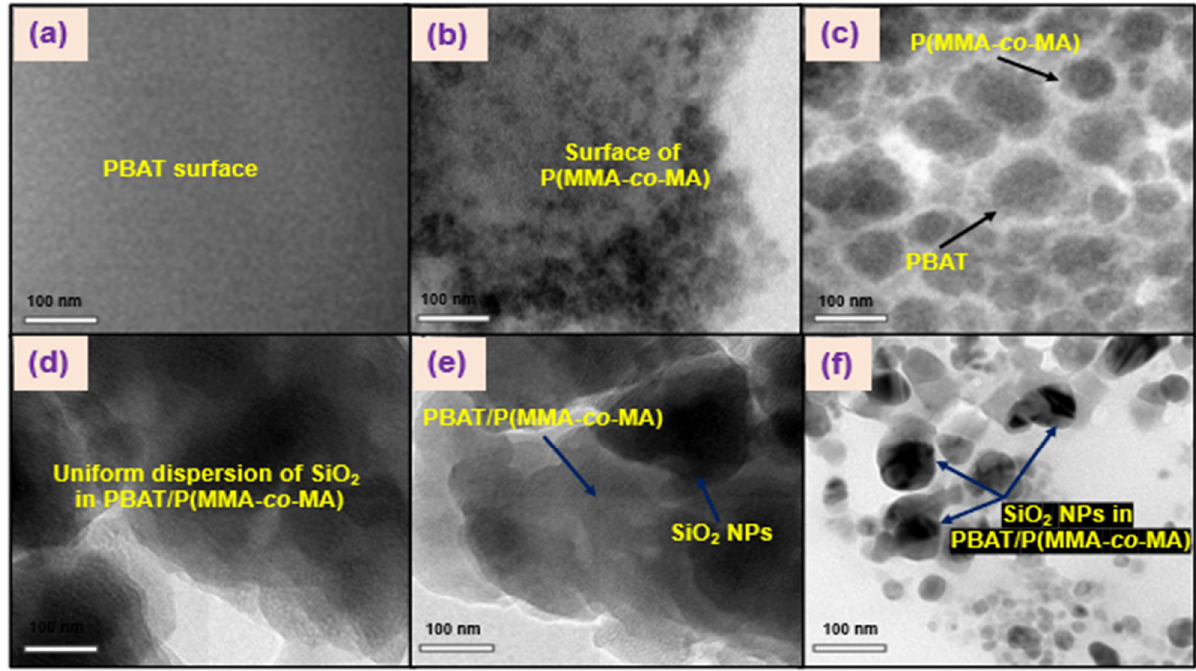
Figure 7. TEM images of PBAT/P(MMA- co -MA)–SiO 2 ternary composites: ( a ) PBAT, ( b ) P(MMA- co -MA), ( c ) PBAT/P(MMA- co -MA) blends, ( d ) PBMS-2, ( e ) PBMS-2, and ( f )